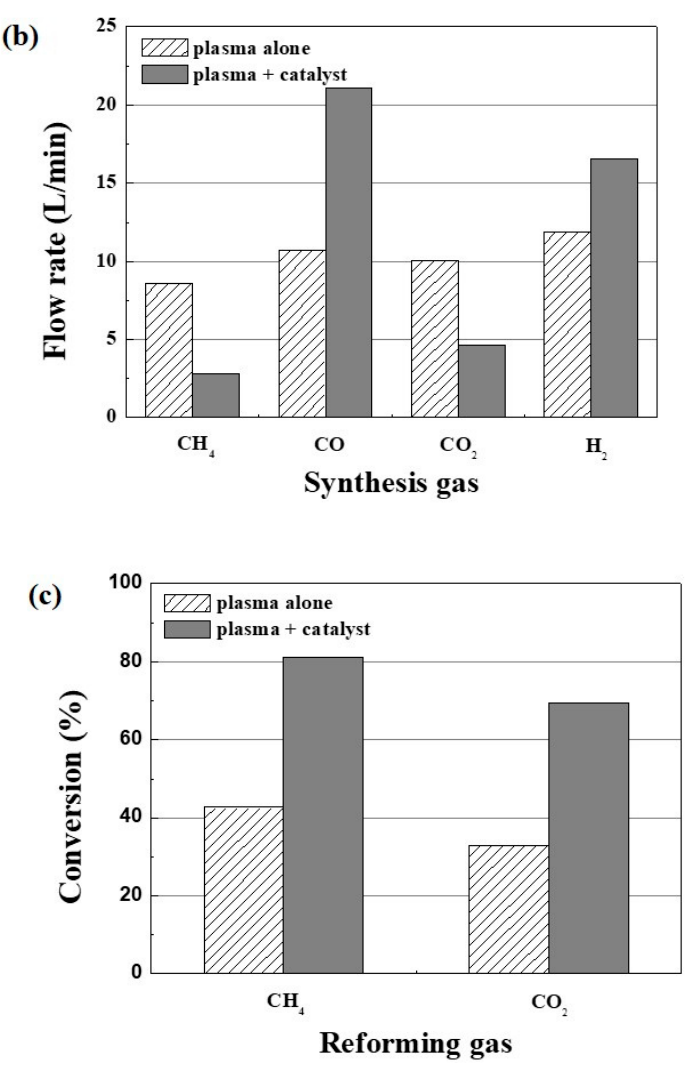
Figure 6. ( a ) Concentration, ( b ) flow rate, and ( c ) conversion ratio obtained with different reforming methods.